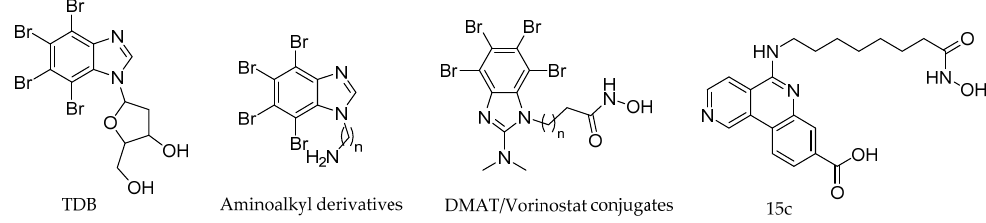
Figure 11. Structures of dual CK2 inhibitors. TDB and the aminoalkyl derivatives target CK2 and PIM1. DMAT/Vorinostat conjugates and 15c target CK2 and HDAC [121,123,125,126].